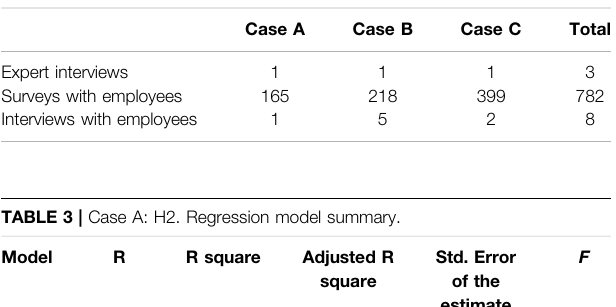
TABLE 2 | Survey and interview participants by case.